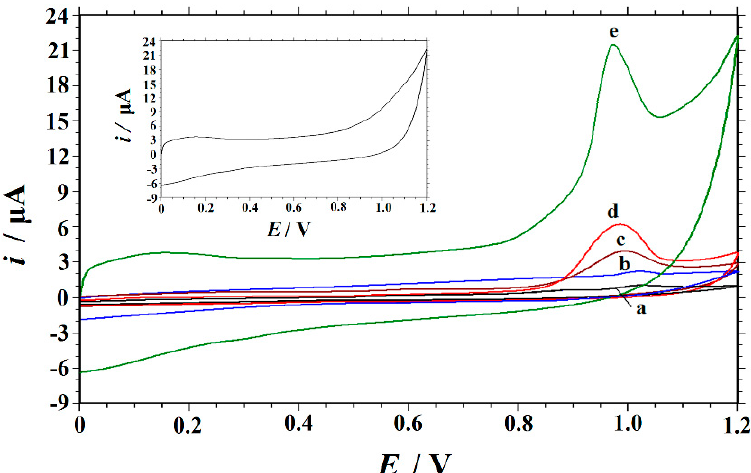
Figure 4. Cyclic voltammograms obtained with di ff erent modified electrodes in a 0.15 M HAc–NaAc bu ff er (pH 6.6) containing 10 µ M of rhodamine B (RhB) at a scan rate of 0.1 V s − 1 . curve a: Bare GCE; curve b: GO / GCE; curve c: Cu 2 O NPs-GO / GCE; curve d: ERGO / GCE; and curve e: Cu 2 O NPs-ERGO / GCE. Inset: The cyclic voltammogram of Cu 2 O NPs-ERGO / GCE in a 0.15 M HAc–NaAc bu ff er (pH